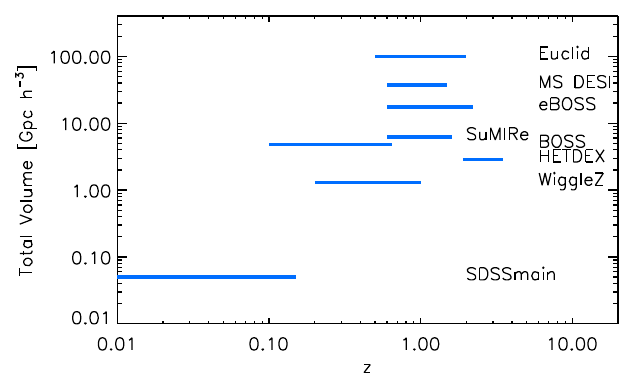
Fig.35 Redshiftcoverageandvolumeforthesurveysmentionedinthetext.Spectroscopicsurveysonlyare shown. Recall that while future and forthcoming photometric surveys focus on weak gravitational lensing, spectroscopicsurveyscanextractthethreedimensionalgalaxyclusteringinformationandthereforemeasure radial and tangential BAO signal, the power spectrum shape and the growth of structure via redshift space distortions. The three-dimensional clustering information is crucial for BAO. For example to obtain the same figure of merit for dark-energy properties a photometric survey must cover a volume roughly ten times bigger than a spectroscopic